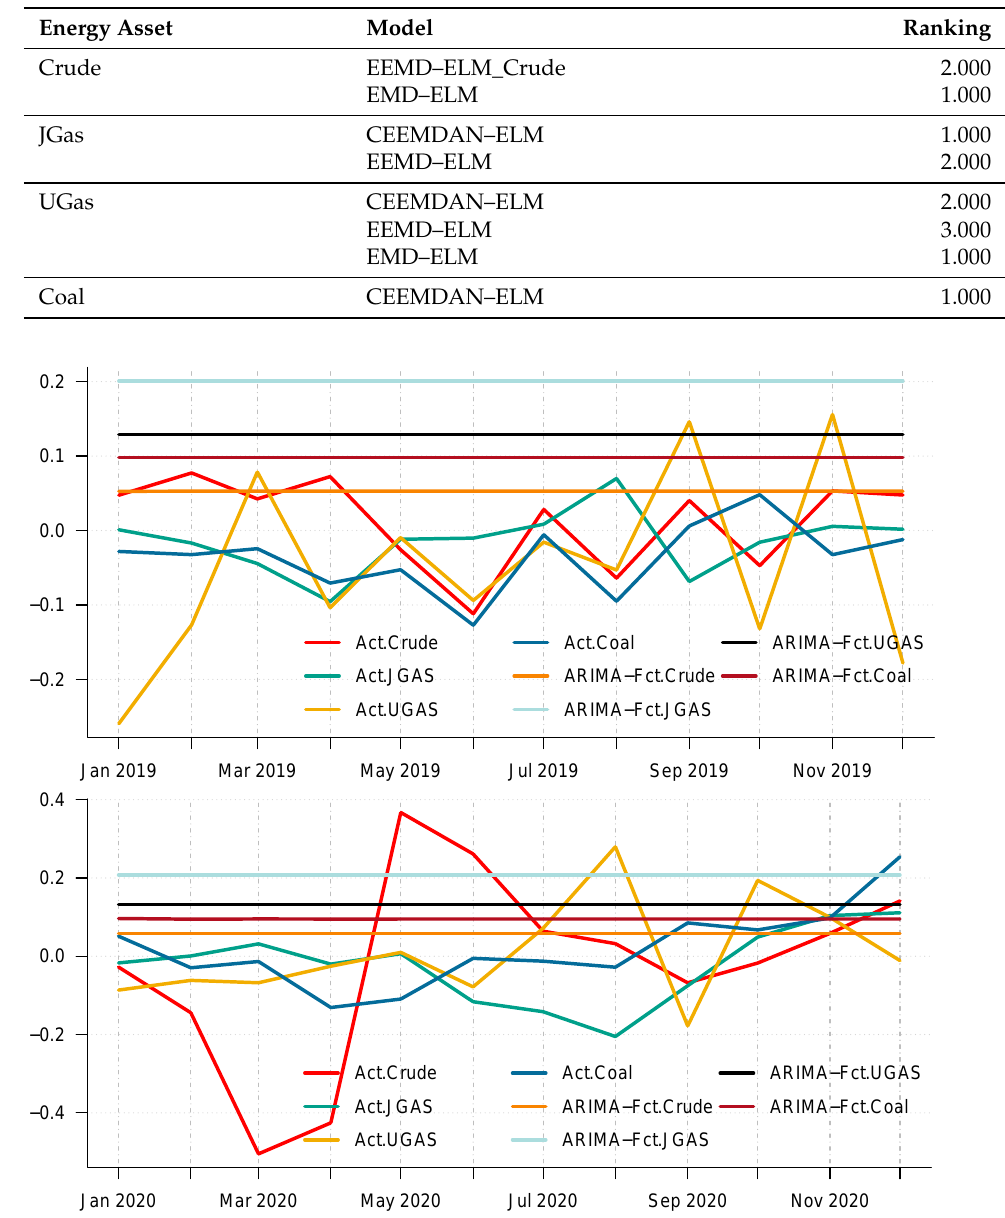
Table 7. Model confidence set: Resulting superiority set of models in 2020.